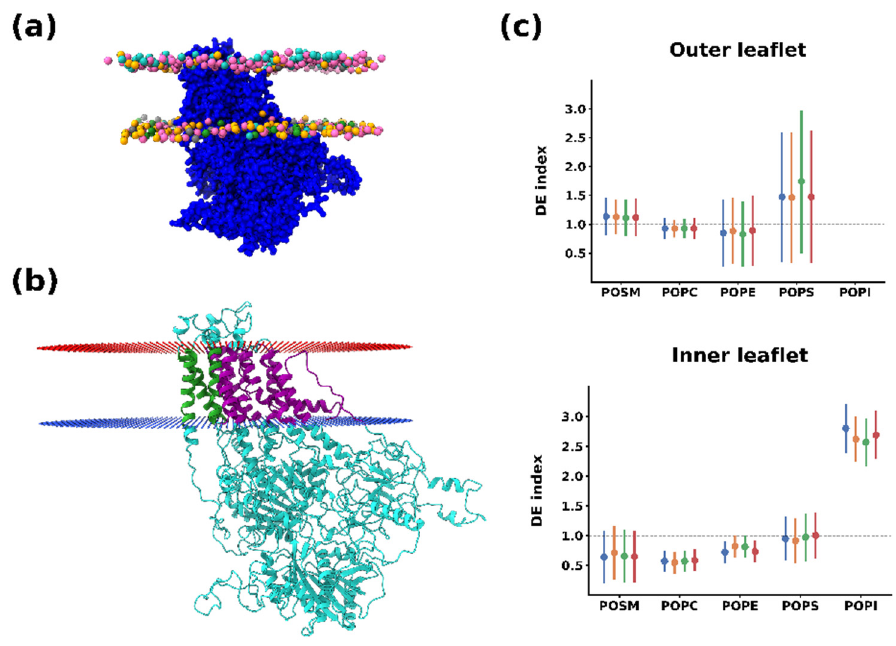
Figure 1. ( a ) System set-up. Lateral view. Each lipid species is colored distinctively (POPC: pink, POPE: orange, POPS: grey, POSM: cyan, and POPI: green). Only lipid phosphate groups are shown. ( b ) All-atom cartoon representation of PcATP2. Protein orientation in the lipid bilayer determined by the PPM server [39] is indicated by red (corresponding to the outer/luminal leaflet) and blue dots (inner/cytoplasmic leaflet). Transmembrane regions of helices 7, 8, and 10 are colored in green. The remaining transmembrane regions are colored in purple. ( c ) Average depletion/enrichment (DE) of lipids as the ratio between the proportion of each lipid species around 0.55 nm of PcATP2 and the ratio of the same species in the membrane composition. Each individual replicate is represented for each lipid with a different color. Error bars represent standard deviations across the whole simulation time. The black dashed line (DE = 1) indicates a homogeneous distribution of the depletion/enrichment index. Values under 1 indicate lipid depletion around PcATP2, while values over 1 indicate an enrichment.